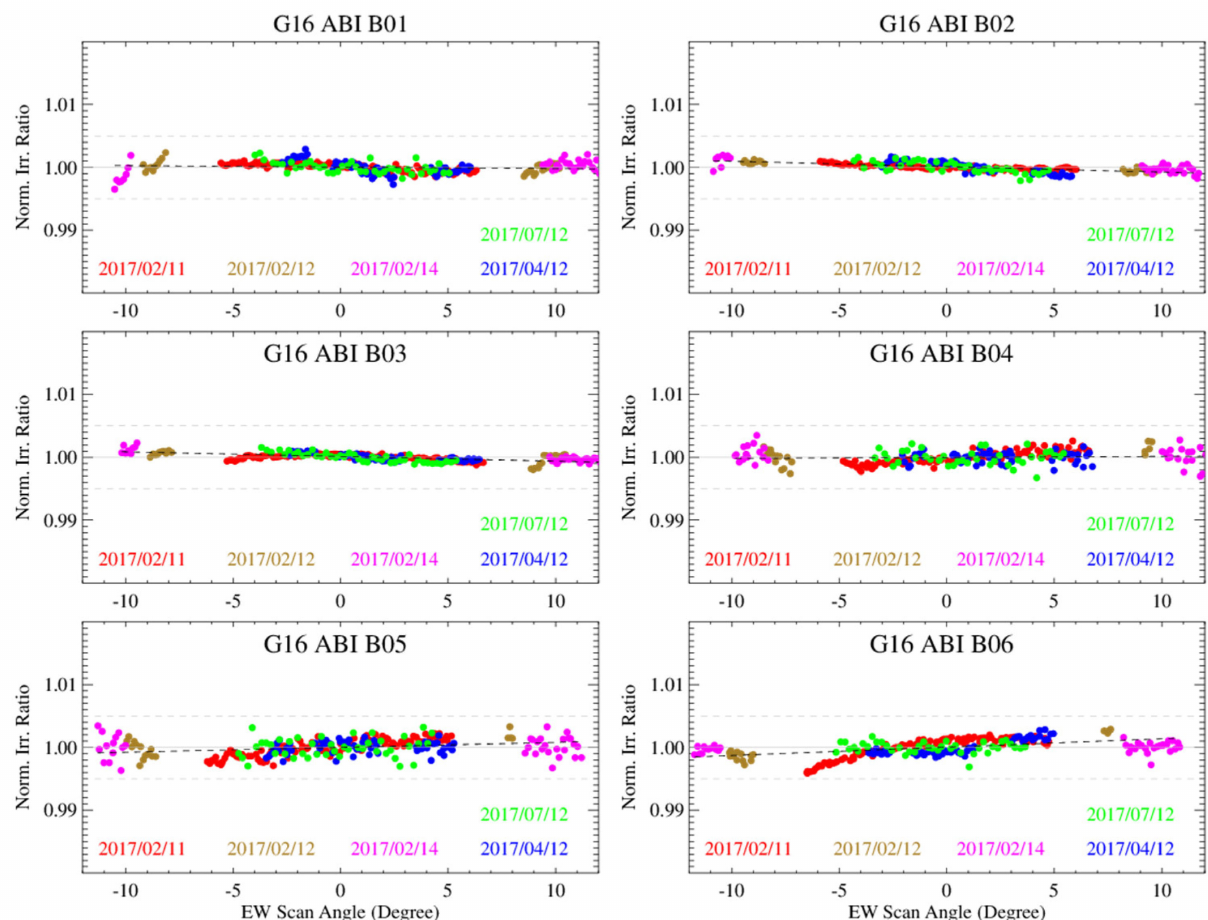
Figure 18. Dependence of lunar irradiance ratio on EW scan angle for G16. The B01–B03 images are calibrated with the corrected spacelook and the L1alpha image straylight